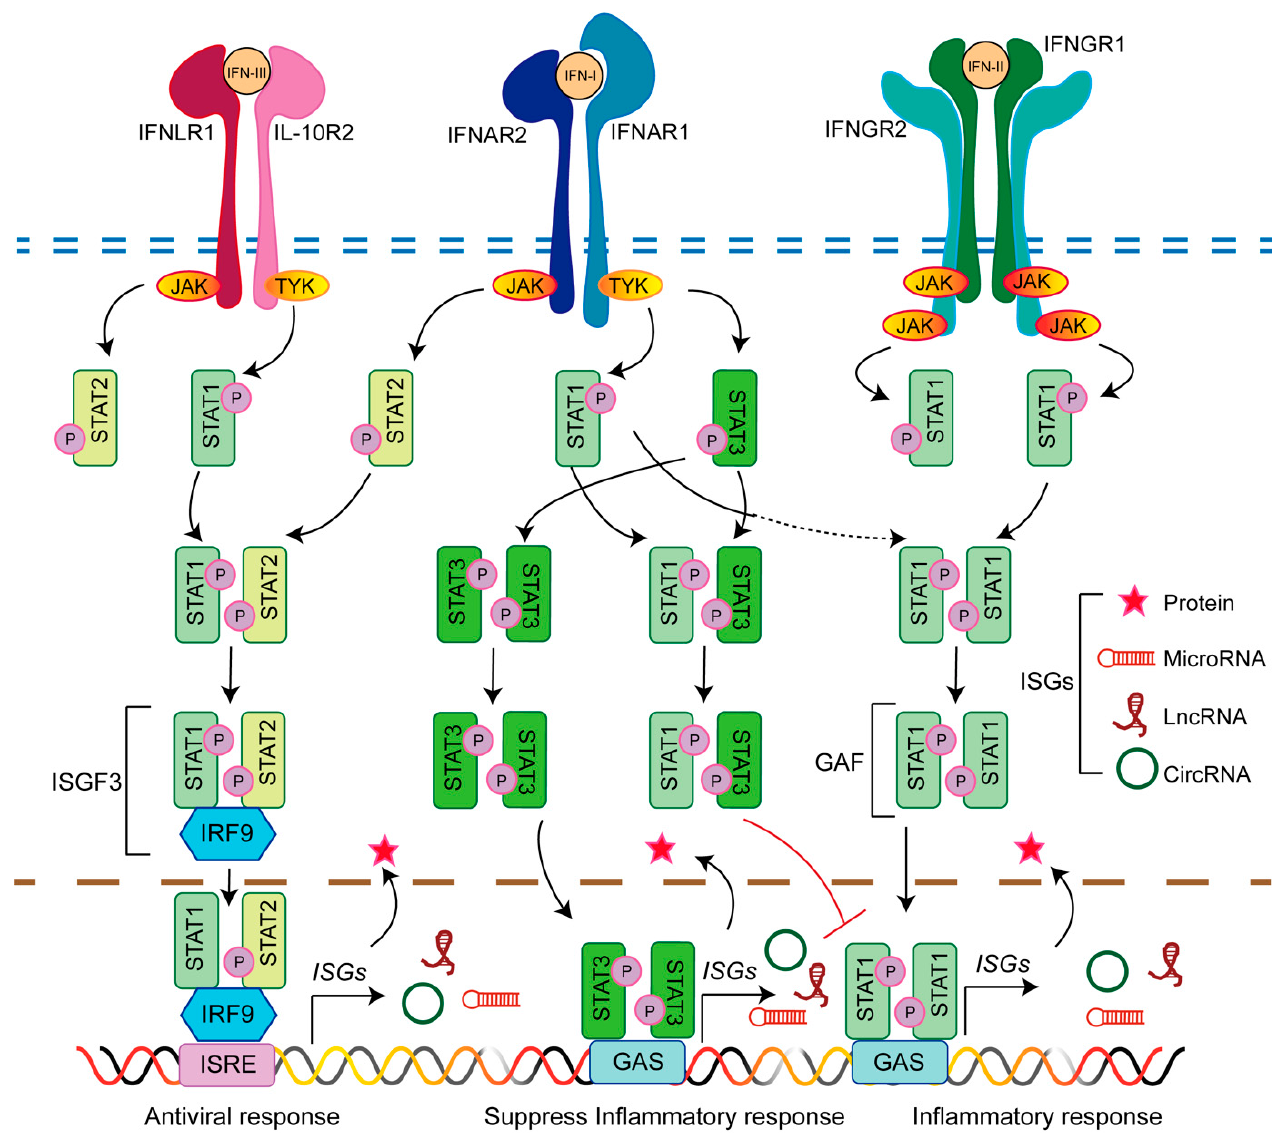
Figure 1. Interferon (IFN)-stimulated gene (ISG) expression. The three types of IFNs trigger similar downstream signal transduction and transcriptional reactions, albeit these reactions are mediated through different receptors. Type I IFN and type III IFN receptors actively phosphorylate JAK1 and TYK2, which phosphorylate the specific intracellular tyrosine residues of the receptors. STAT1/2/3 are recruited and phosphorylated. Type II IFN receptors trigger the phosphorylation of bound JAK1 and JAK2, and then phosphorylate receptor chains to induce the recruitment and phosphorylation of STAT1. STAT1 and 2 form a heterodimer that recruits IRF9 to form IFN-stimulated gene factor 3 (ISGF3), which is translocated into the nucleus and binds to IFN-stimulated response element (ISRE) sequences to trigger antiviral gene expression. STAT3 homodimers suppress proinflammatory gene expression. STAT1 homodimers bind to the gamma-activated sequence (GAS) to activate the inflammatory response. Phosphorylated STAT3 sequesters activated STAT1 to form heterodimers and prevent STAT1 from forming functional homodimers that trigger downstream gene expression. Gamma-activated factor (GAF).